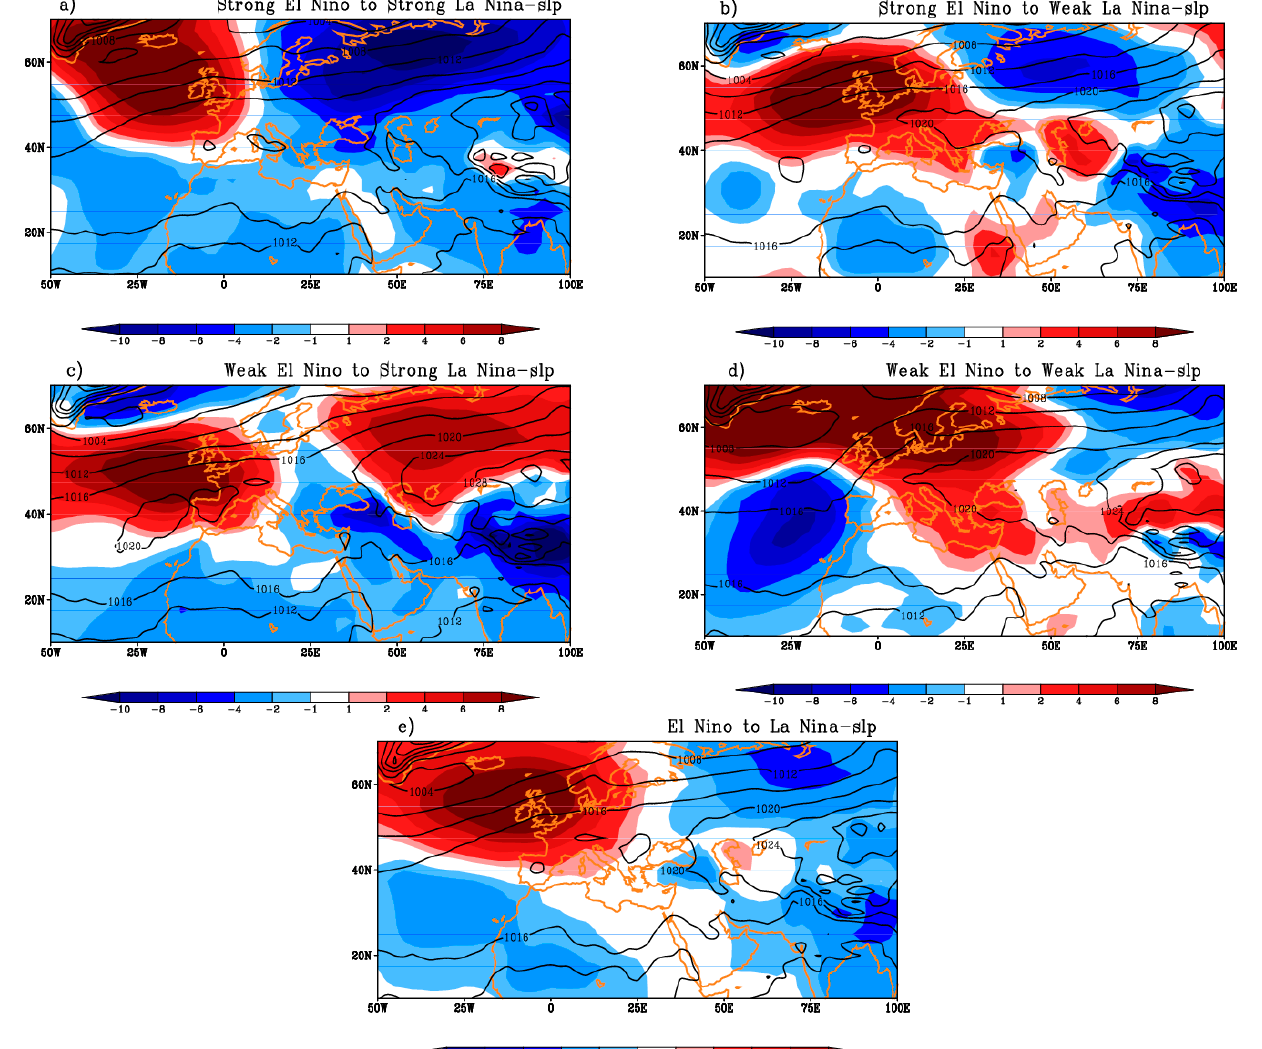
Figure 5. Autumn anomalies of sea level pressure for type 1 transitions. Positive (negative) anomalies are colored blue (red). Panels ( a – d ) show patterns for different cases, while panel ( e ) shows the average over all the type 1 cases. Units are hPa.